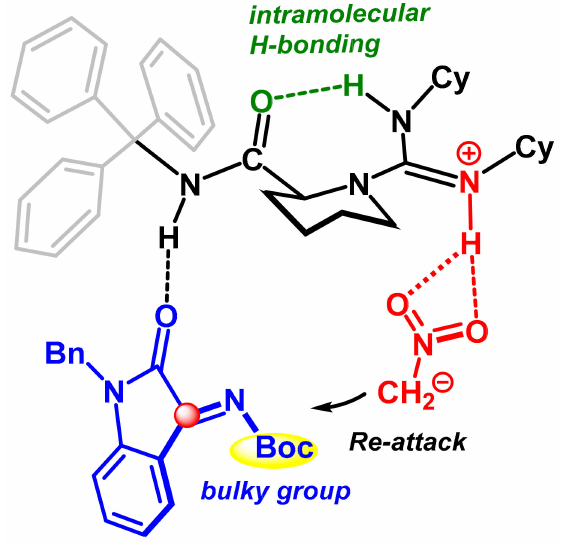
Figure 8. Origin of enantioselectivity in the aza-Henry reaction.